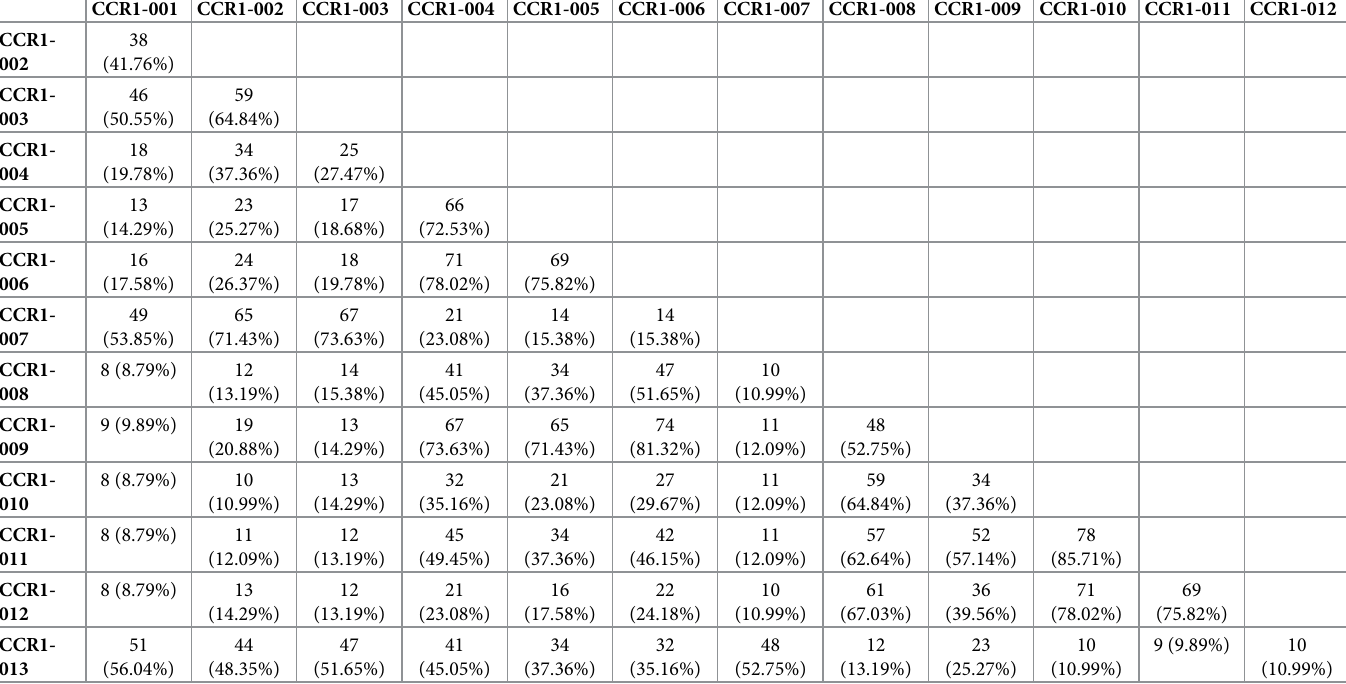
Table 3. The number (percentage) of concordant RFs before ComBat harmonization between pairwise combinations of scans with different acquisition and